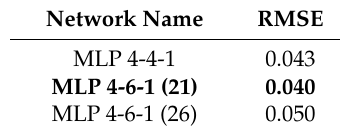
Table 7. The RMSE values for three MLP neural network (based on four